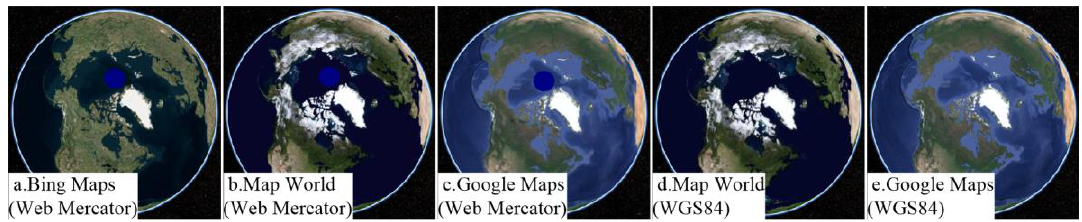
Figure 1. Tile loading effect with a single data source in 3D